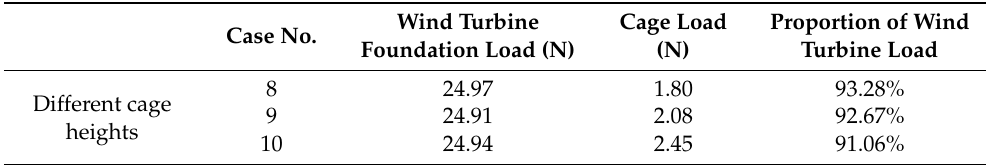
Table 4. Maximum horizontal load distribution and proportion of the combined structure under different cage heights and